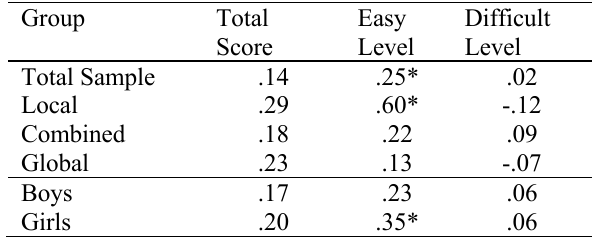
Table 2: Pearson Correlation between Accuracy in the CWMR Test and Spatial WM in the Total Sample, in Each Group of Self-Report of Strategy, and for Boys and